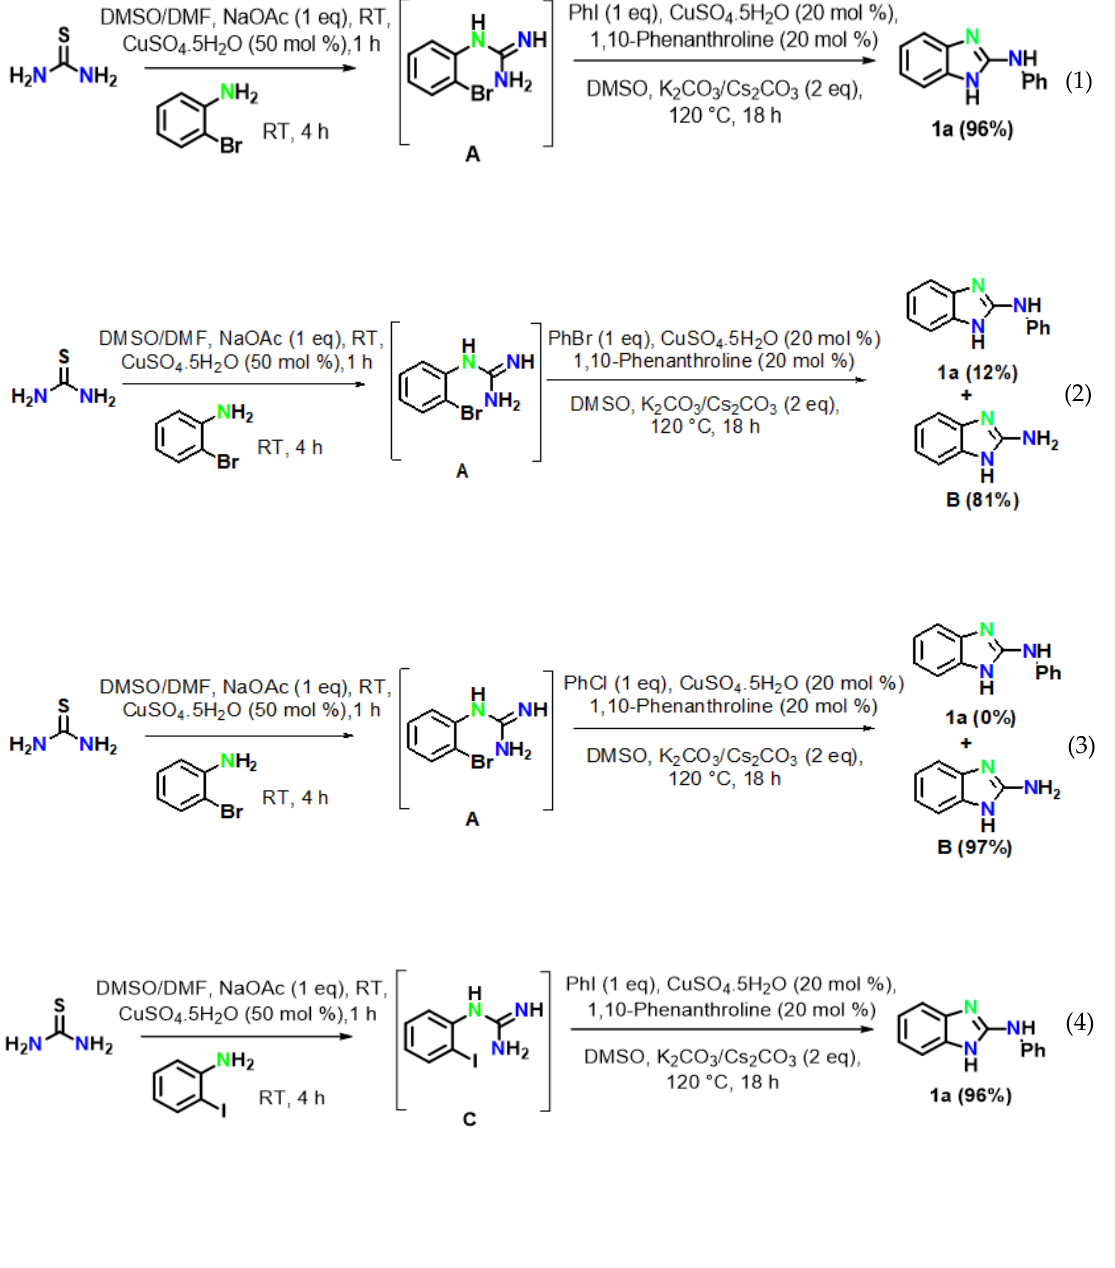
Figure 2. Substrate scope evaluation; Reaction conditions: thiourea (1 mmol); DMSO (2 mL) ; NaOAc (1 equiv); CuSO 4 .5H 2 O (50 mol%), 1 h, room temperature; 2-bromo aniline/substituted 2-bromo aniline (2 mmol), room temperature, 4 h; Next, ArI (1 mmol); CuSO 4 .5H 2 O (20 mol%); 1,10-